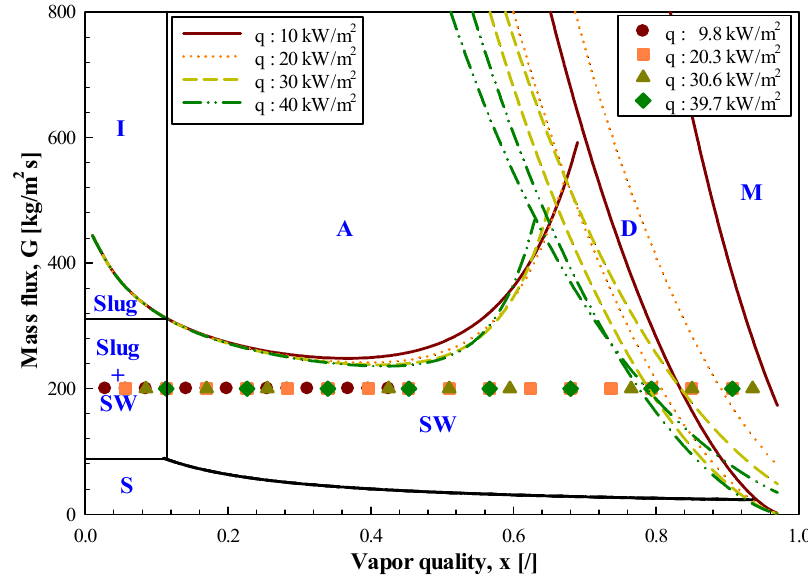
Figure 6. Flow pattern map for R744 according to various heat fluxes at constant mass flux (200 kg/(m 2 ·s)) and saturation temperature ( − 20 °C).